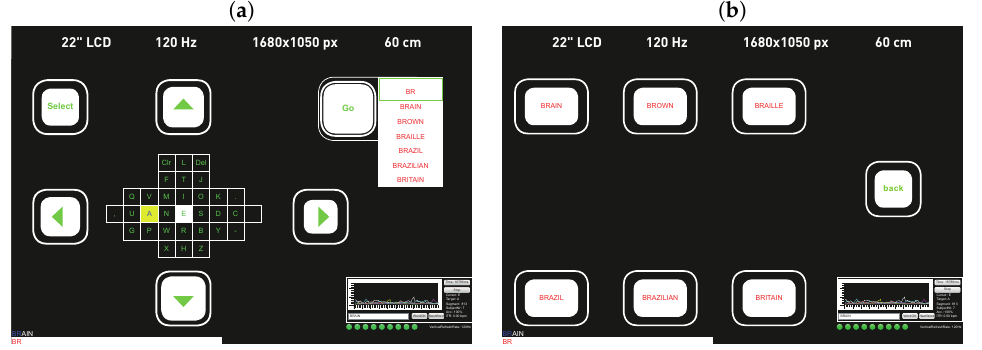
Figure 12. ( a ) The modification of the original Bremen-BCI speller when a build-in dictionary was added to it [28]; ( b ) The second stage of the GUI, where suggested words were presented to the user to choose the desired